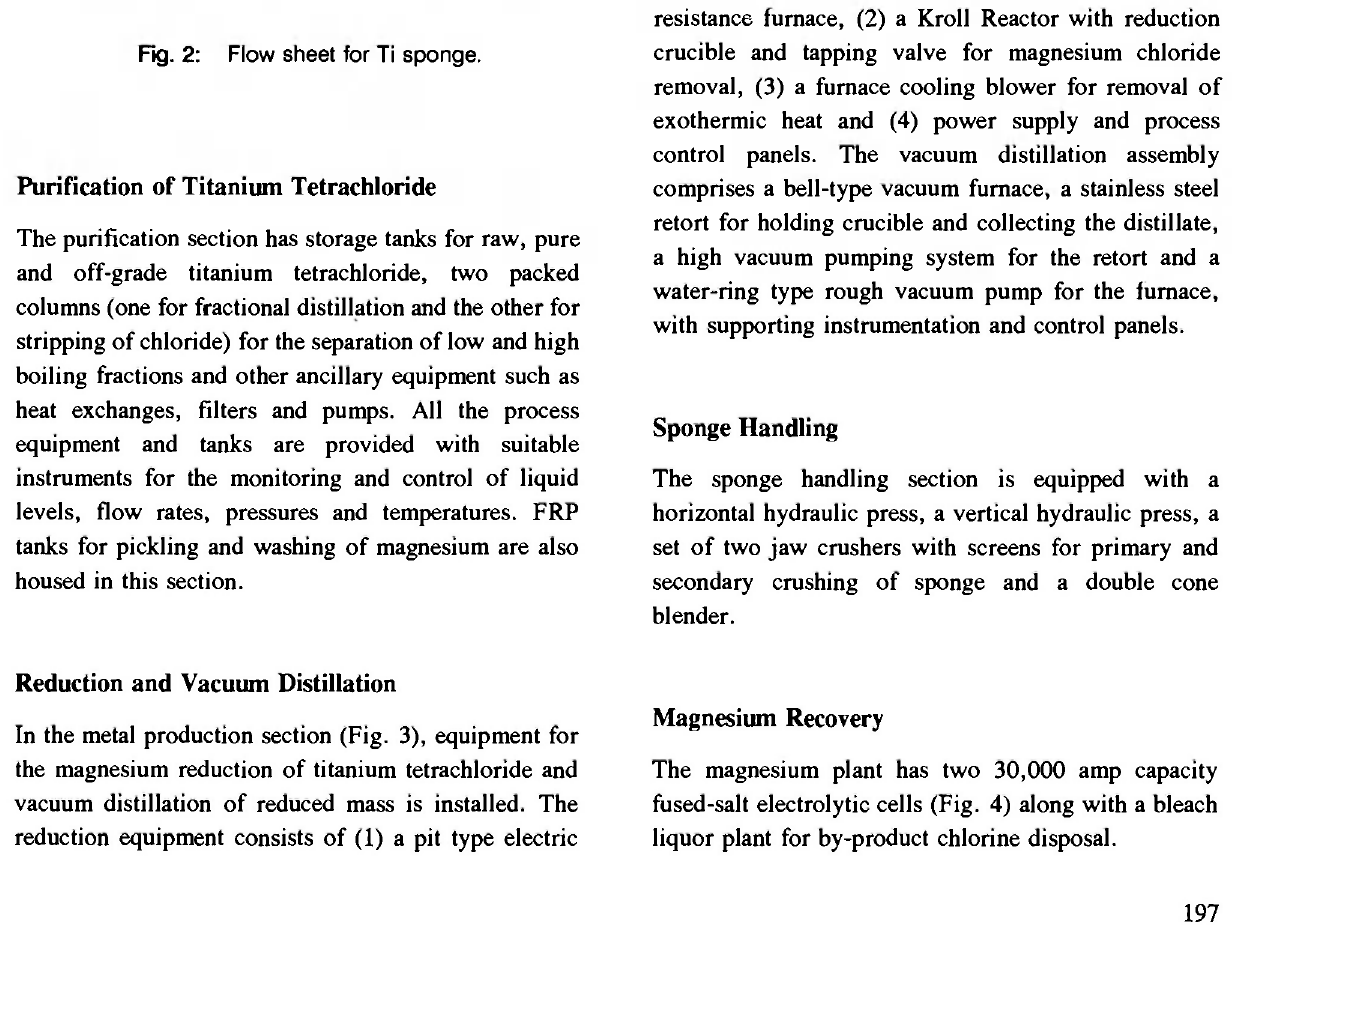
Fig. 3: Sponge production bay.